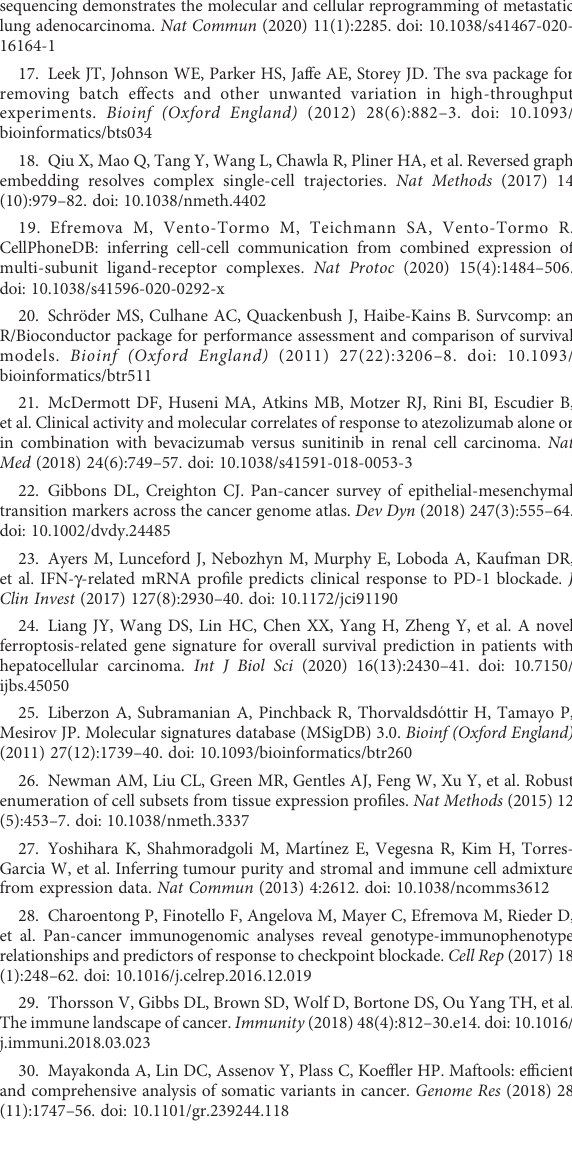
SUPPLEMENTARY FIGURE 2 Subgroup Cox analysis of FRS Subgroup Cox regression analysis of FRS in TCGA (A) and GEO (B) cohorts. SUPPLEMENTARY FIGURE 3 Prediction of FRS-related small molecule